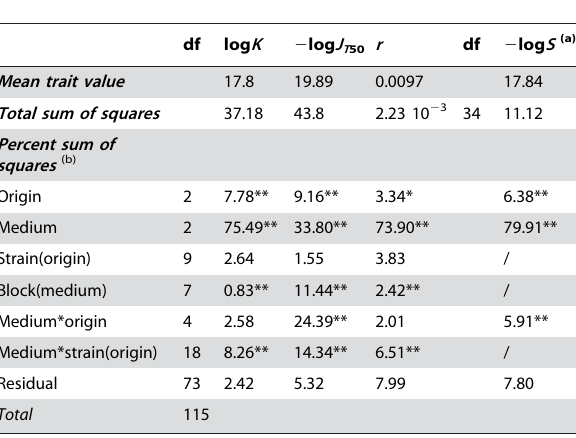
Table 2. Mean trait value and ANOVAs’ results for carrying capacity (log K ), glucose consumption rate ( 2 log J T 50 ), growth rate ( r ), and cell size ( 2 log S